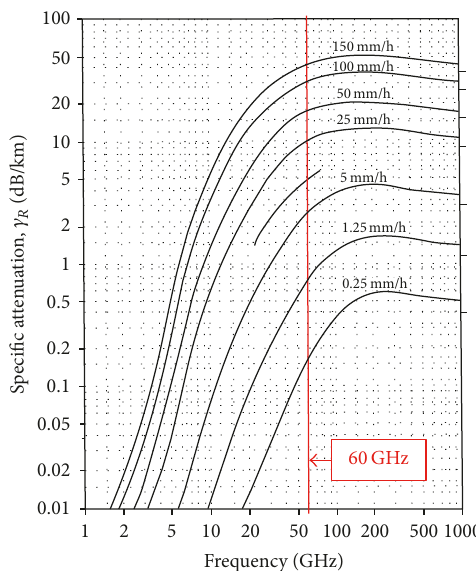
Figure 5: Rain attenuation factor estimation from FCC measure- ment results